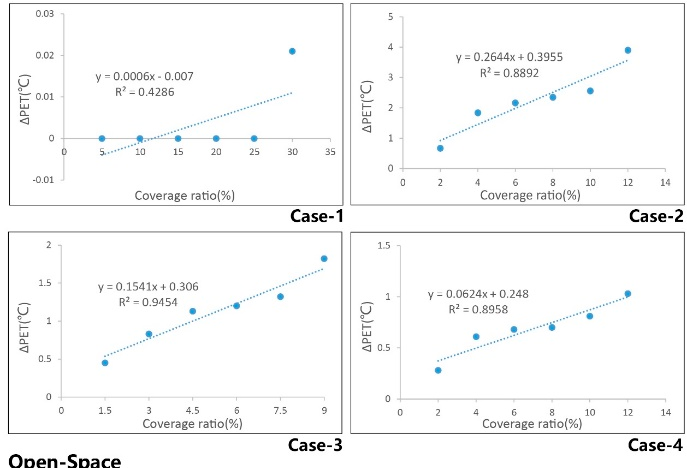
Figure 20. Correlation between thermal comfort and the coverage ratios of different parameters in open space at 14:00.